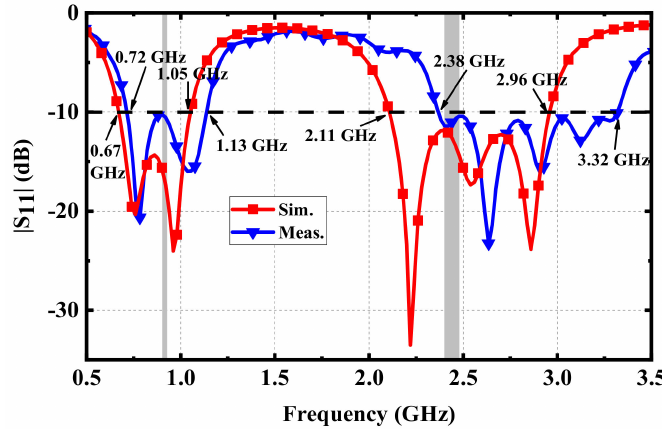
Figure 12. Comparison between simulation and